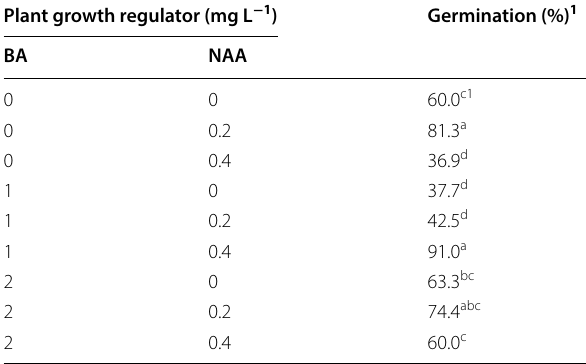
Table 1 Influence of BA and NAA concentrations on seed germination in F. cirrhosa